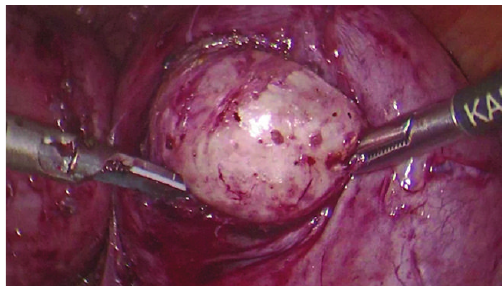
Figure 3: Leiomyoma enucleation in the fundal right segment of the bicornual uterus. Minimal invasive techniques were performed utilizing only two operative trocars with a third one at the umbilicus for the lens insertion.